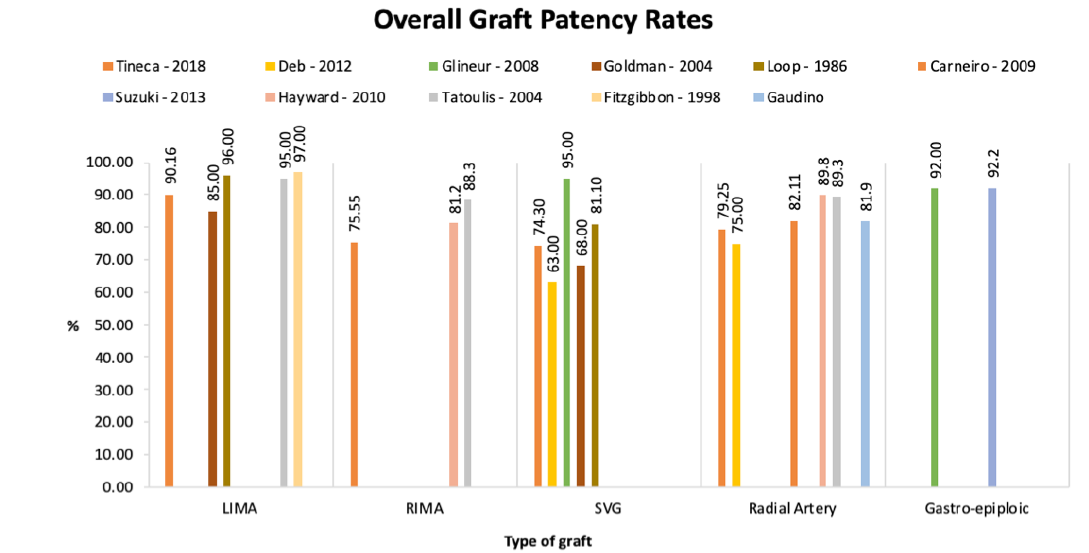
Fig. 1 – Patency rates of five different grafts types. LIMA=left internal mammary artery; RIMA=right internal mammary artery; SVG=saphenous vein